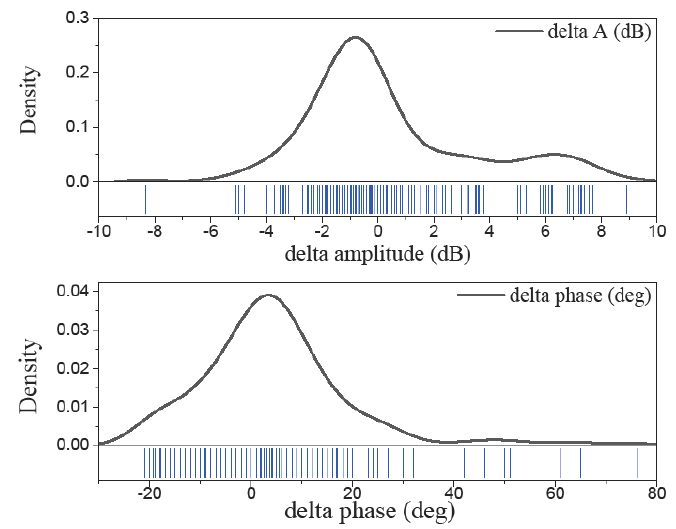
Figure 4. A rug plot of two hundred data points. ( upper panel ) Delta amplitude distribution. ( lower panel ) Delta phase distribution, that appears in blue along the X ‐ axis. The points are sampled from the kernel smooth distribution shown in black.